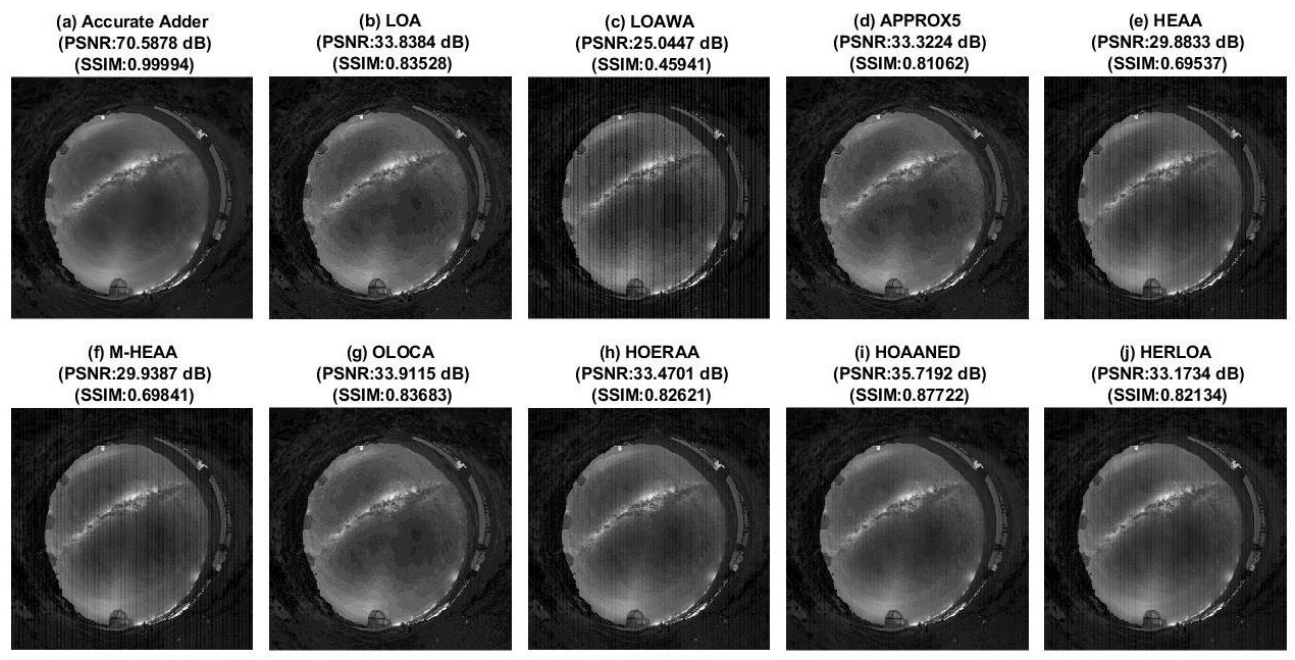
Figure 4. La Silla image compressed using accurate adder and different approximate adders, with the approximate adders having an 11-bit inexact part.